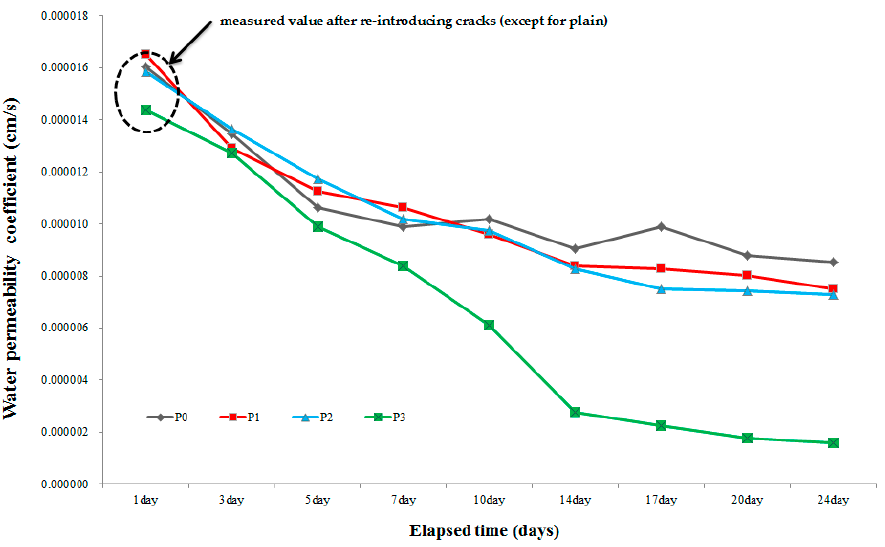
Figure 13. Results of the water permeability test.